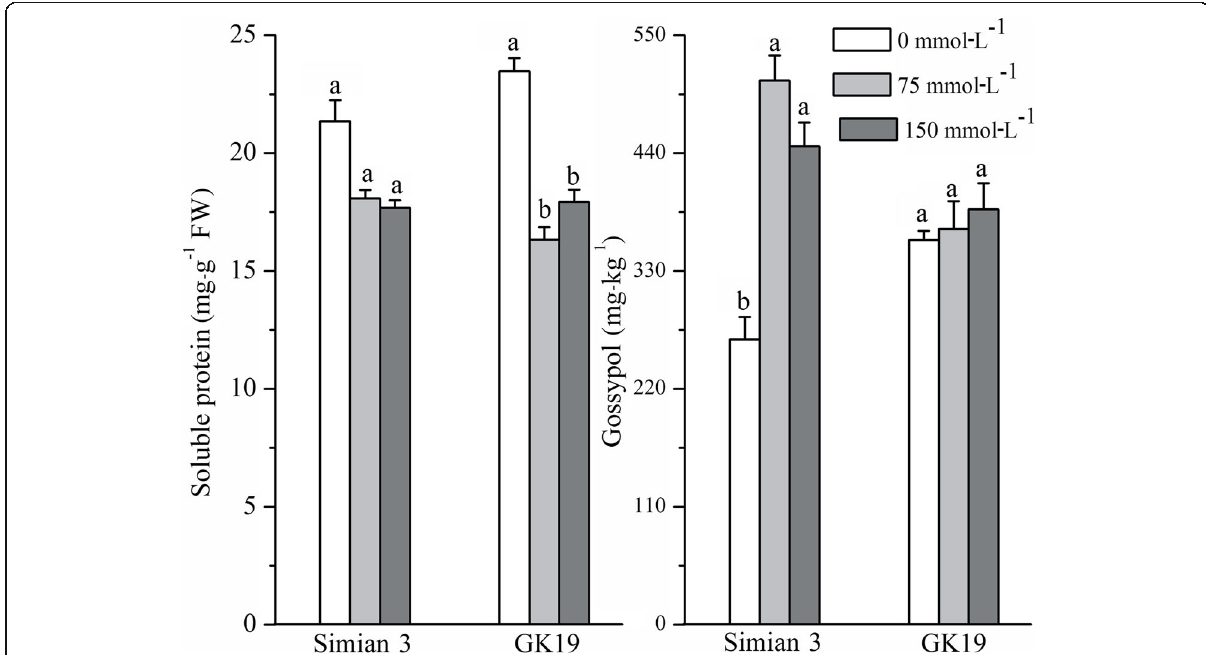
Fig. 3 Effects of NaCl stress on the soluble protein and gossypol contents in GK19 and Simian 3. Mean ± (SE); Significant difference in lowercase letters at 0.05 level between NaCl stress